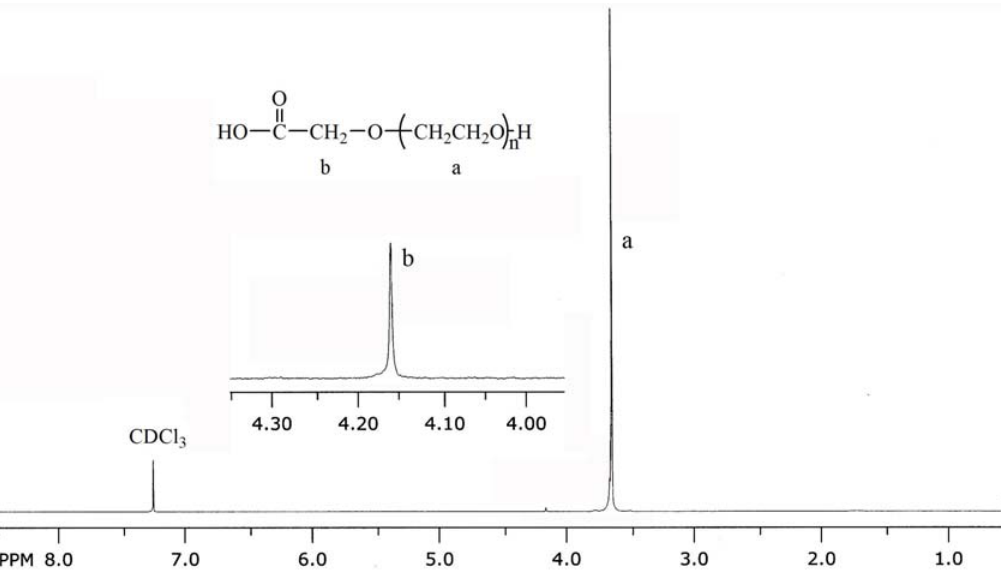
Figure 1. 1 H NMR spectrum of poly(ethylene glycol) with ω -carboxyl group and α -hydroxyl